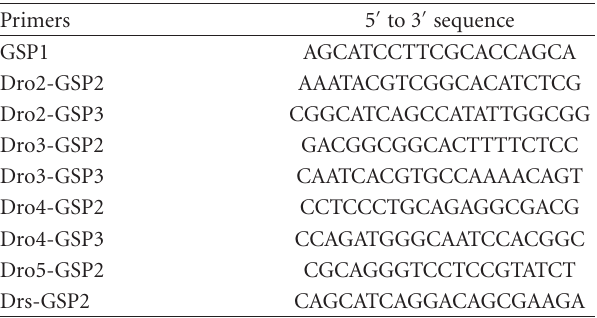
Table 2: Primers for 5 (cid:2) RACE reactions. The GSP1 sequence was corresponded to positions 190 ∼ 208 in the ORFs of Dro1 and Dro5, 193 ∼ 211 in Dro2 and Drs, 196 ∼ 214 in Dro3 and Dro4, and 199 ∼ 208 in